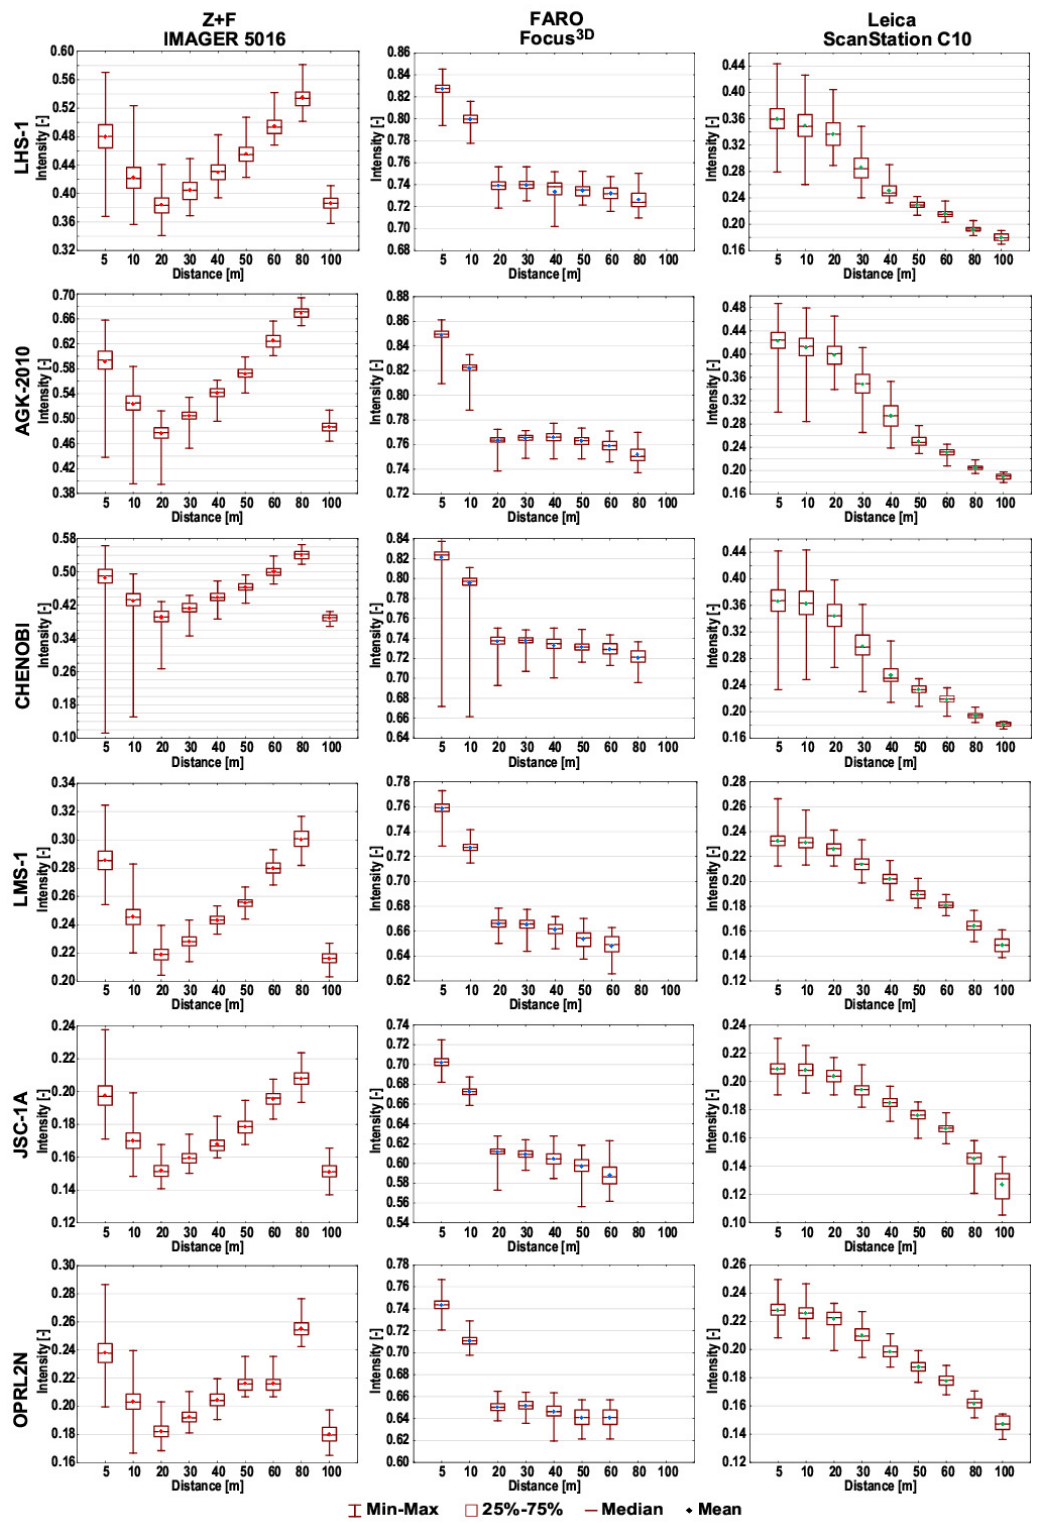
Figure 7. Box plots of the intensity data from TLS measurements.